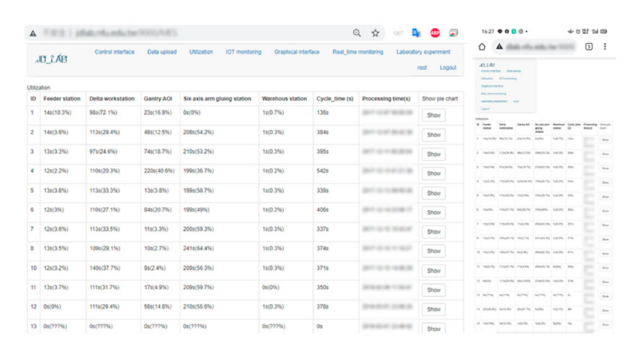
Figure 17. Utilization-rate display interface.